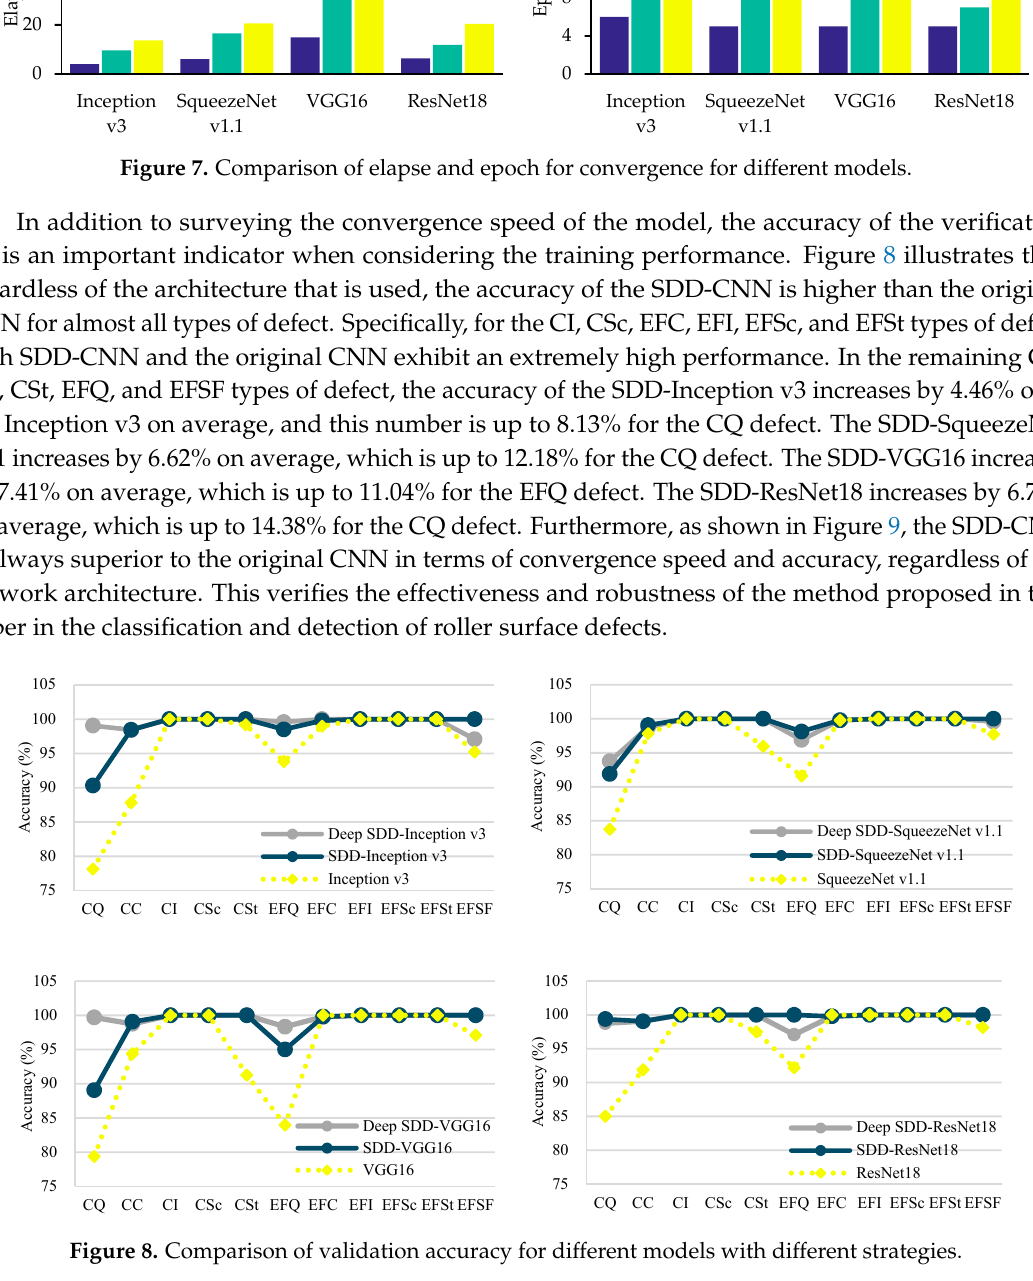
Figure 8. Comparison of validation accuracy for different models with different strategies.